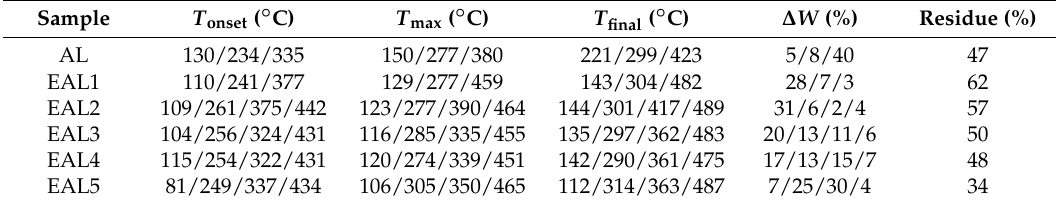
Table 2. TGA characteristic parameters for the original alkali lignin and epoxidized lignin